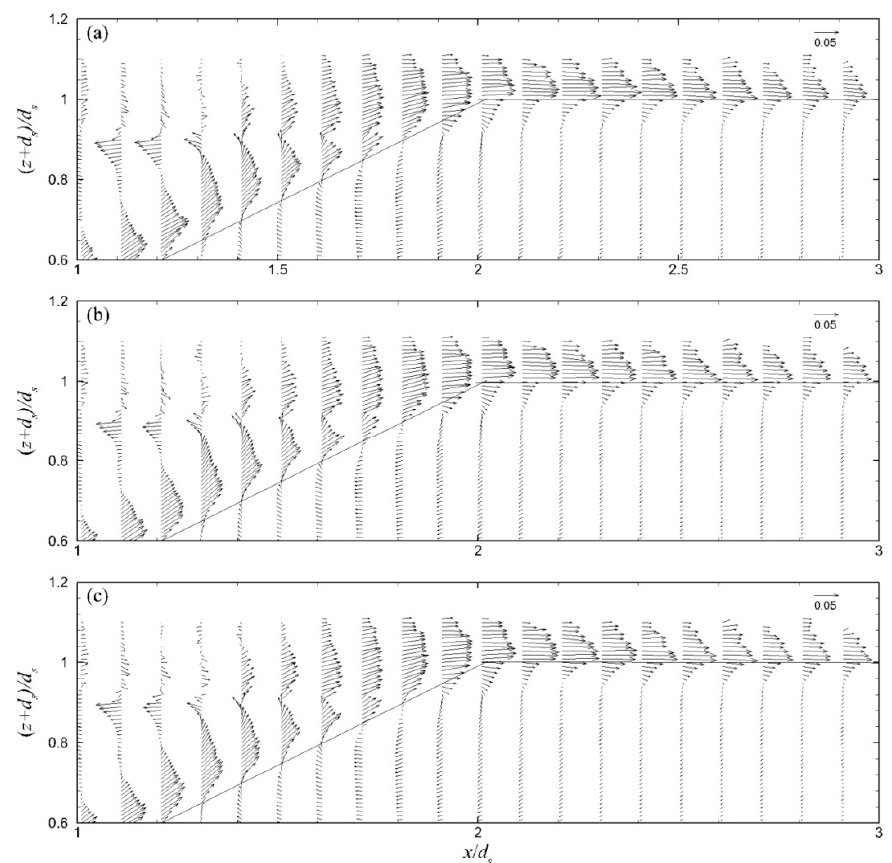
Figure 10. Period-mean velocity field in the seaward region of the ZFBs in cases: ( a ) 1, ( b ) 2, and ( c ) 3. Velocity vectors are shown non-dimensionalized by ( gd S ) 1 / 2 in the water phase under the wave crest envelope.